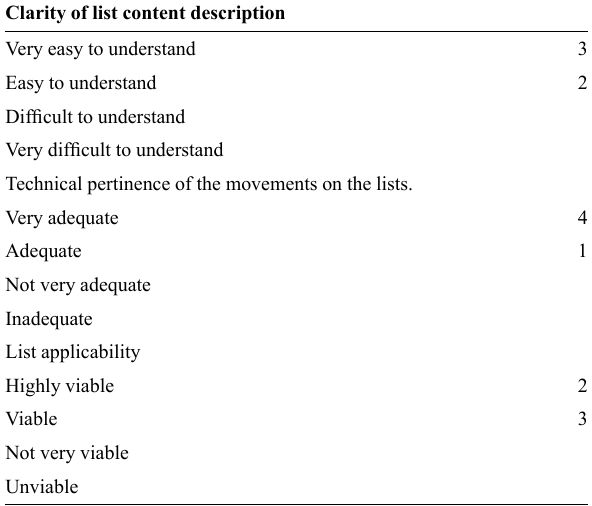
Table 2 - Result in the number of evaluators of the content analysis per- taining to the content description clarity, the technical pertinence of the movements, and the applicability of the lists.